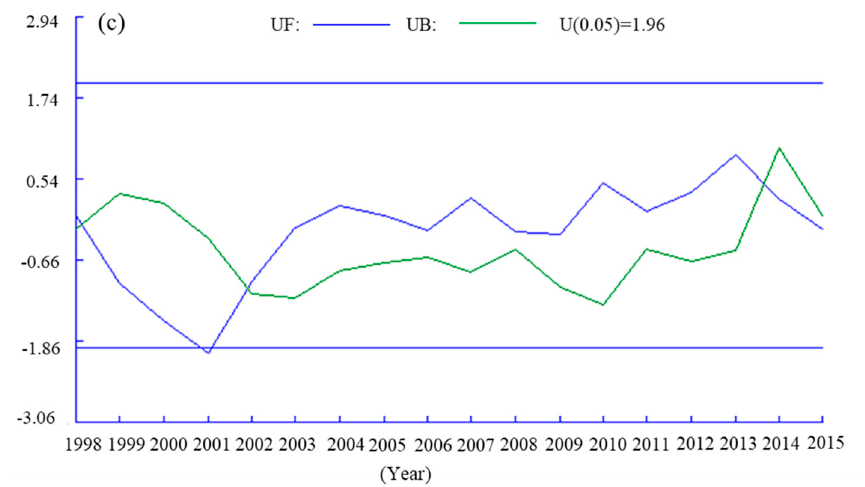
Figure 4. ( a ) Yearly average NDVI from 1998 to 2015 and ( b ) point analyses of trend variations; (c) Mann– Kendall test.